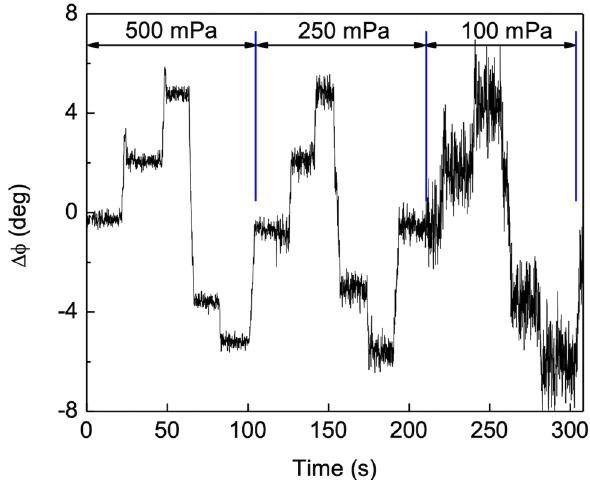
Figure 12. Recorded phase shift time series. Recorded phase shifts between left and right signals for three SPLs (500, 250 and 100 mPa). The time instant on which the SPL was reduced from the previous value is marked by the vertical blue lines. The steps in the recorded signal are due to turntable position changes. Turntable positions are 0°, 2°, 4°, − 2° and − 4°. The increase in the phase shift uncertainty is clearly noticeable after a SPL reduction.